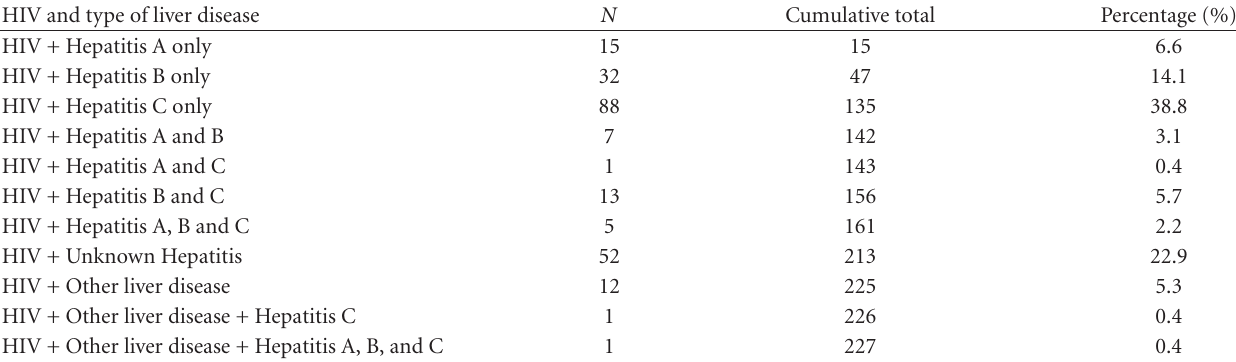
Table 3: Classification of comorbid types of liver disease ( n = 227).